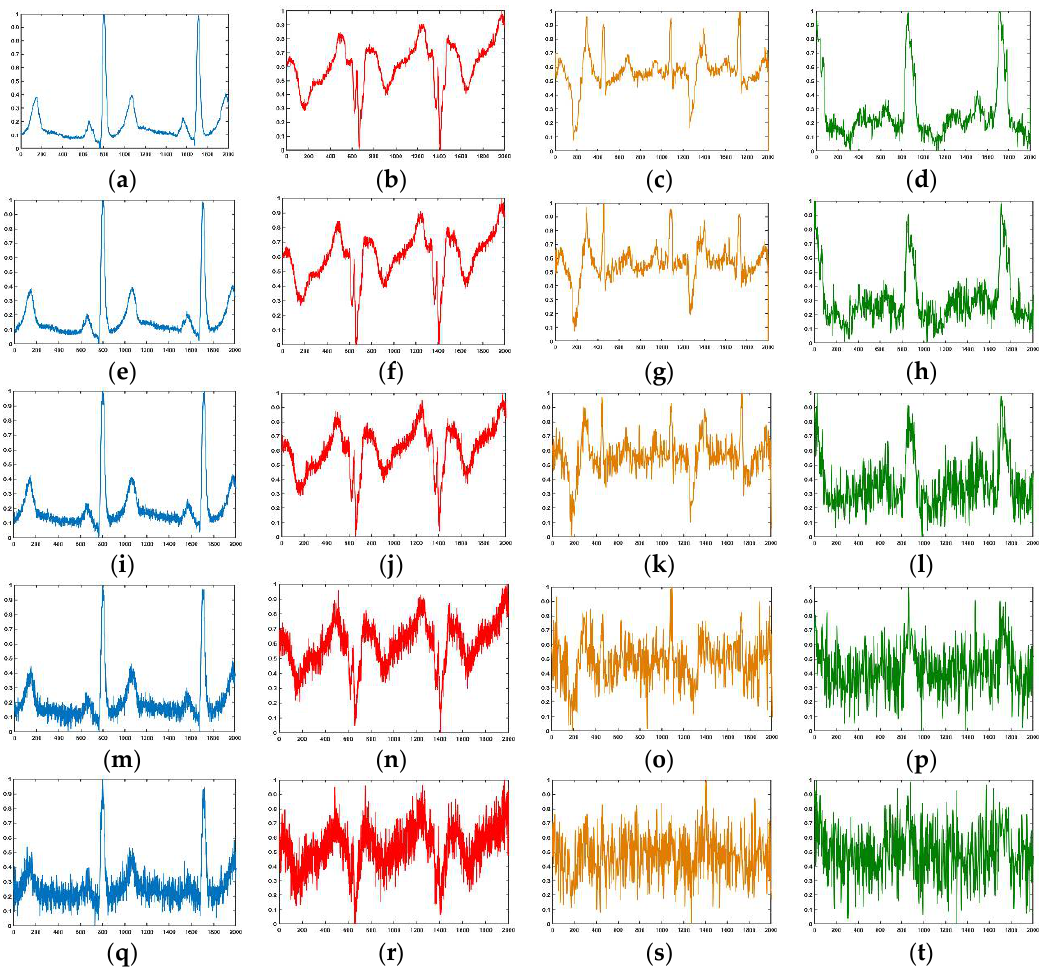
Figure 11. The noisy segment with different SNR. From left to right: Normal, MI, CAD, and CHF. ( a – d ) SNR = 24 dB; ( e – h ) SNR = 18 dB; ( i – l ) SNR = 12 dB; ( m – p ) SNR = 6 dB; ( q – t ) SNR = 0 dB.